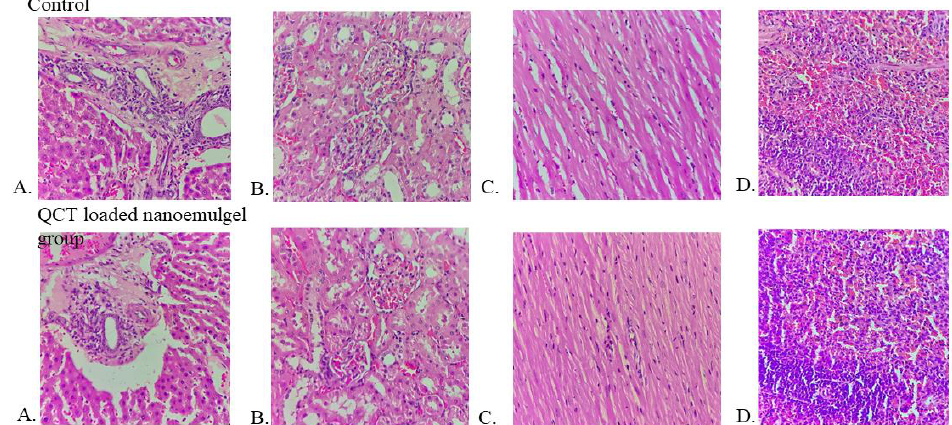
Figure 11. Histopathology study of QCT@NG. ( A ) Liver, ( B ) kidney, ( C ) heart and ( D ) spleen showed no significant changes in the treated group as compared to control.